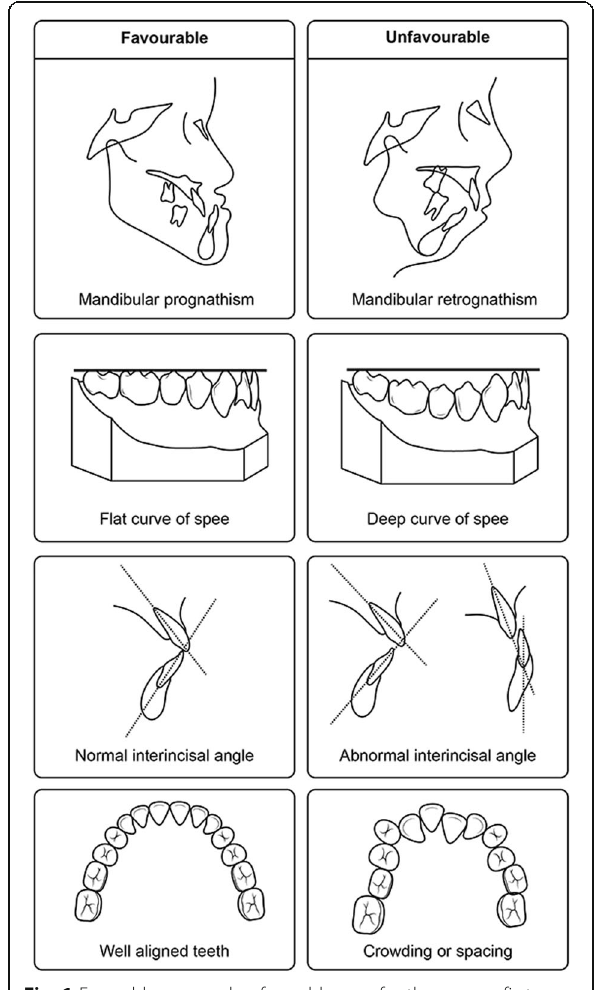
Fig. 1 Favorable case and unfavorable case for the surgery-first approach. Some unfavorable cases may be considered for the surgery-first approach. However, much more sophisticated treatment plan is required for unfavorable